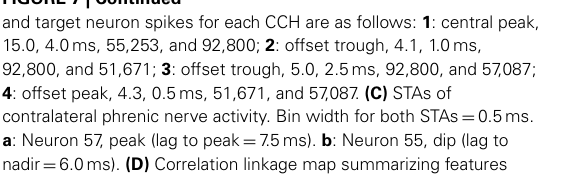
found in all CCHs calculated for the group of four neurons in (B). Each large “sphere” represents a neuron and contains that neuron’s ID code and direction of change in firing rate when tracheal stimulation elicited a cough; the cell’s respiratory-modulated firing pattern is indicated by the color of the sphere (see Key).White, black, and gray circles at the ends of the lines between spheres represent central or offset peaks or troughs (see Key). Circled numbers indicate corresponding CCHs shown in (B)